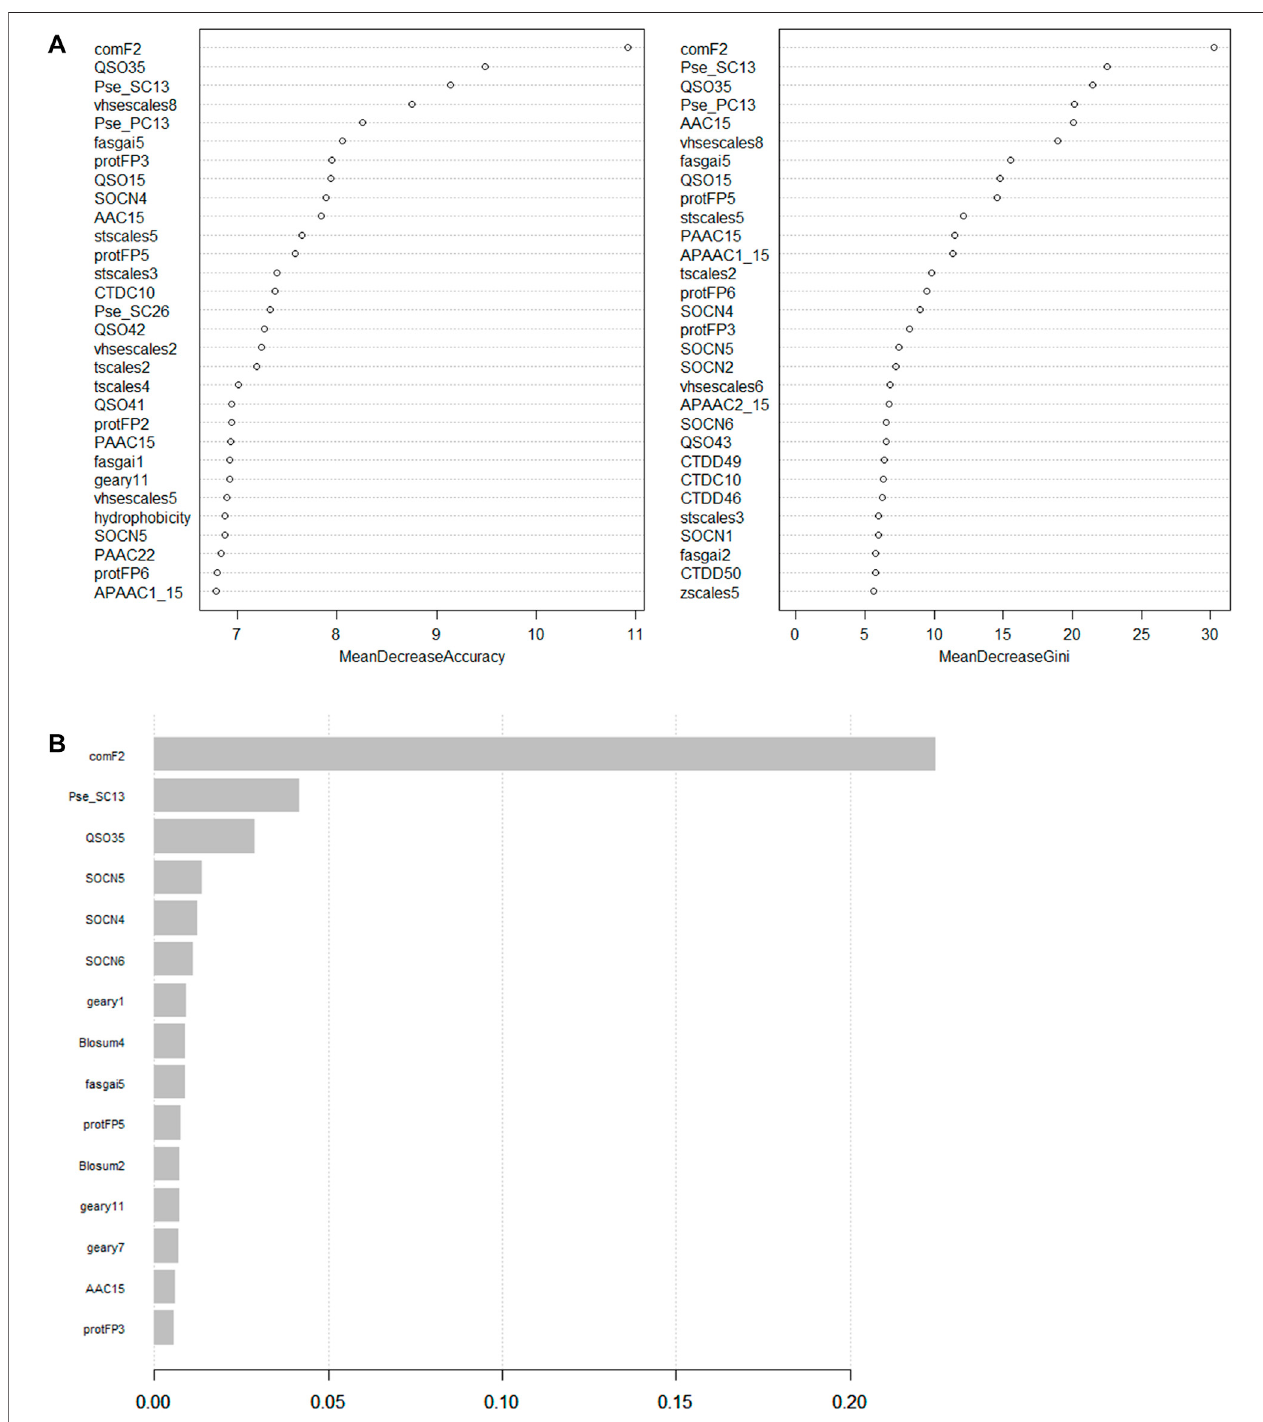
FIGURE7| ImportanceplotsandSHAPplot: (A) ImportanceplotsyieldbytheRF(left:permutationimportance;right:Giniimportance). (B) Importanceplotyielded by the XGB model. (C) SHAP summary plot of the top 15 features; (D) dependence plot of composite feature comF2 for the AHTP class. (E) Density distribution of the SHAP plot ’ s top six features (sample) by class in the training